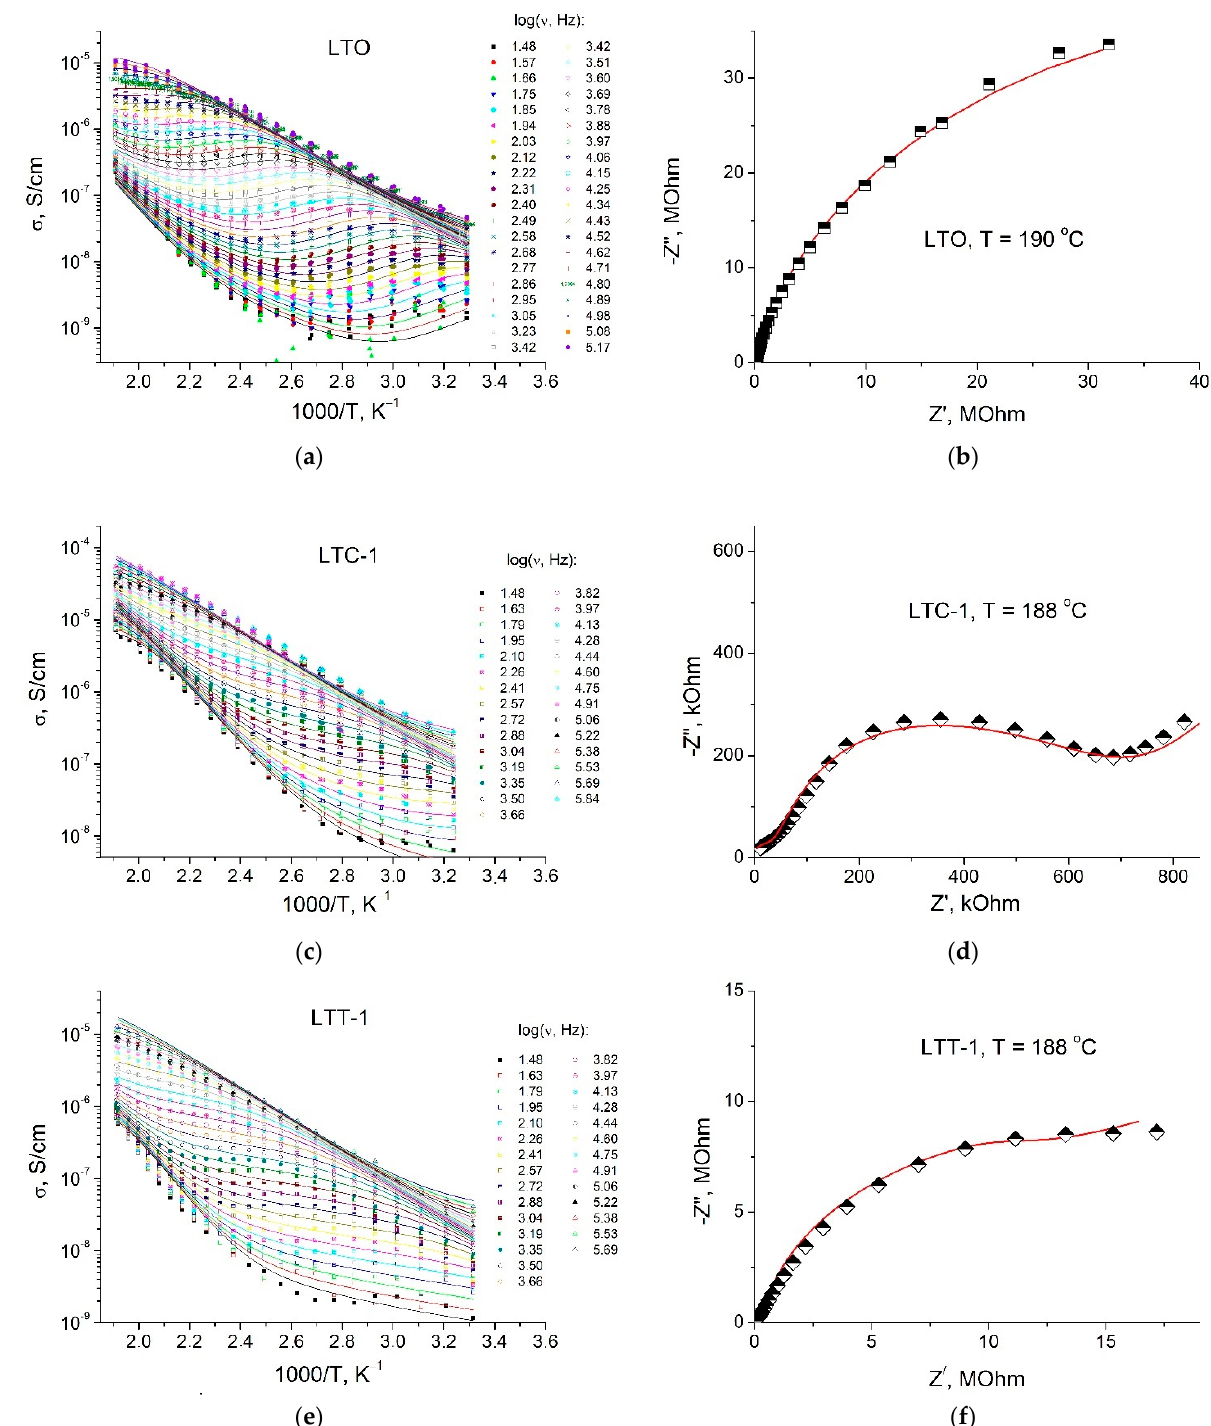
Figure 4. Temperature dependences of the real part of conductivity, measured at different frequencies (indicated in the plots) ( a , c , e ) and Nyquist plots ( b , d , f ) obtained at temperatures 188–190 °C for LTO, LTC-1 and LTT-1 samples. Dots are experimental values; lines are theoretical curves obtained as a result of fitting.